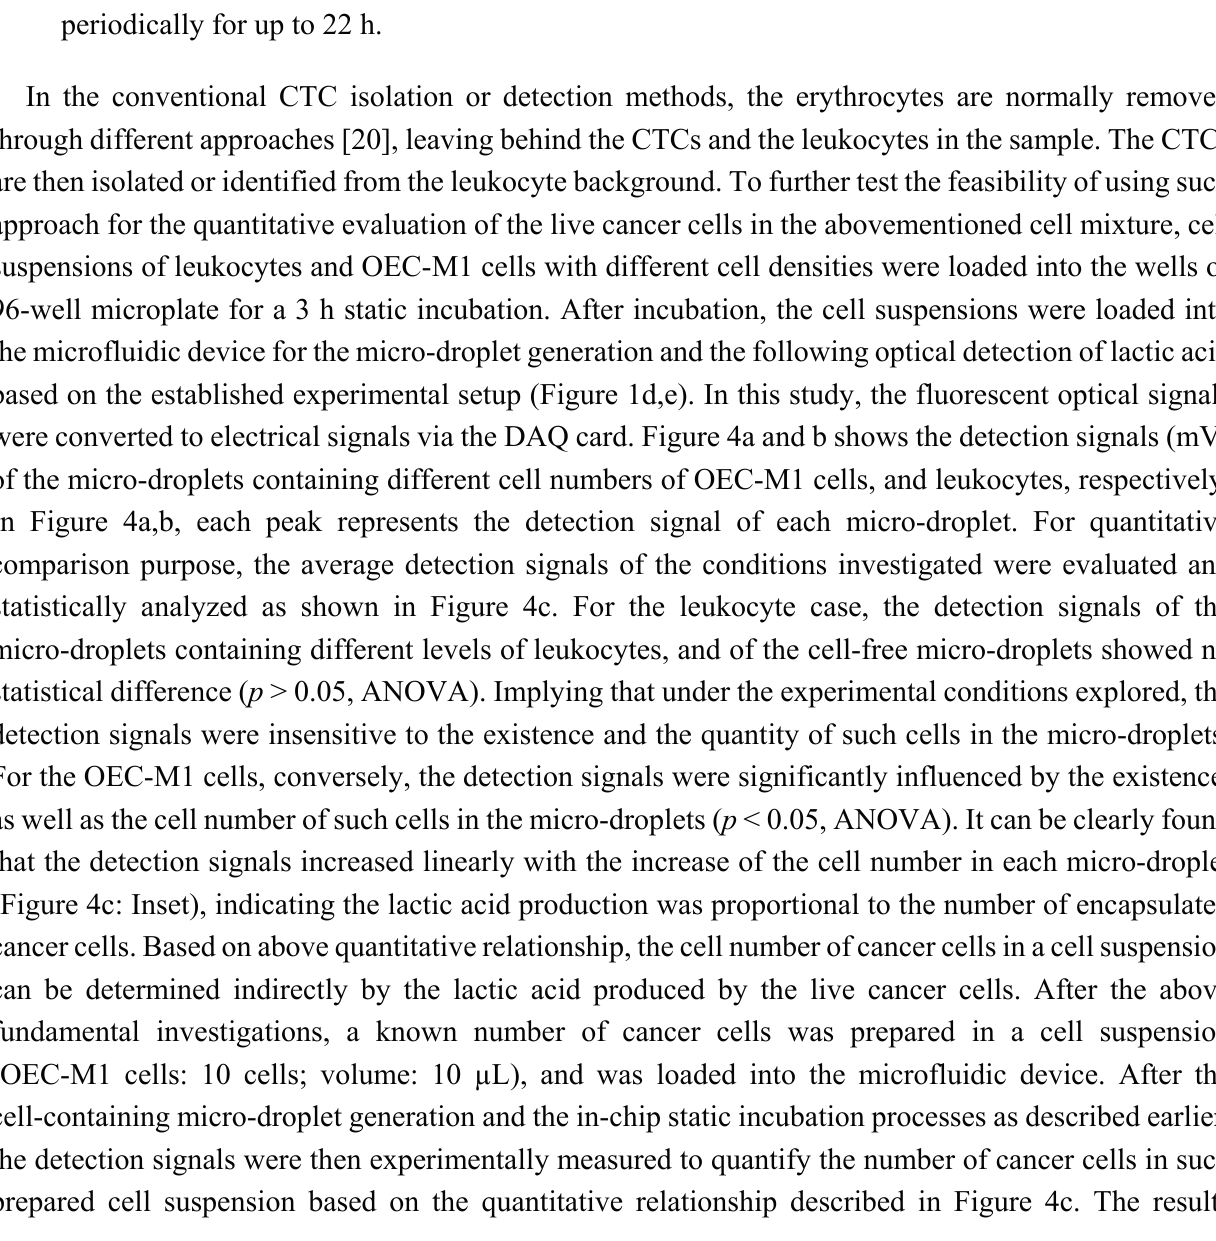
Figure 3. The observation of fluorescent intensity with time. The fluorescence-based lactate reagent was mixed with lactate solution. The fluorescence detection was carried out periodically for up to 22